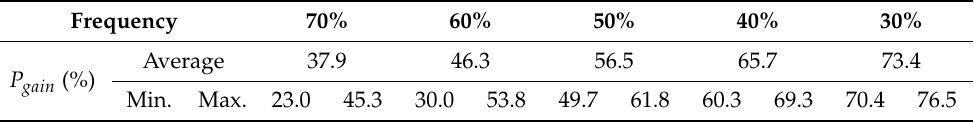
Figure 9. Monte Carlo simulation results of the power gain for each required frequency. Table 1. Average and extreme values of P gain for each required